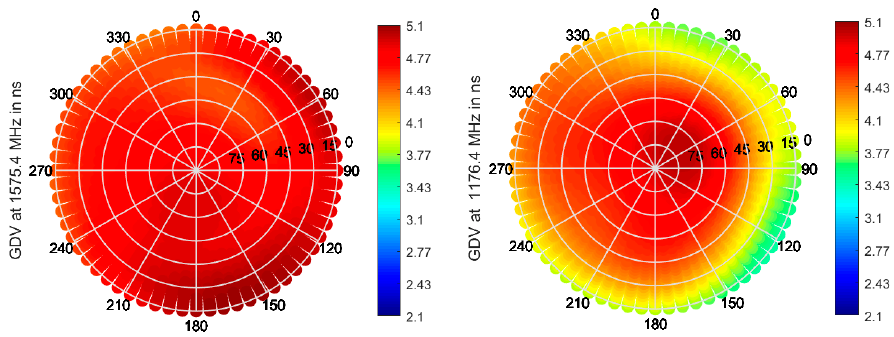
Figure 8. GDV in the upper hemisphere at L1/E1 ( left ) and L5/E5a ( right ) for the ANYWAVES GNSS All-Bands Antenna, with data provided by manufacturer.